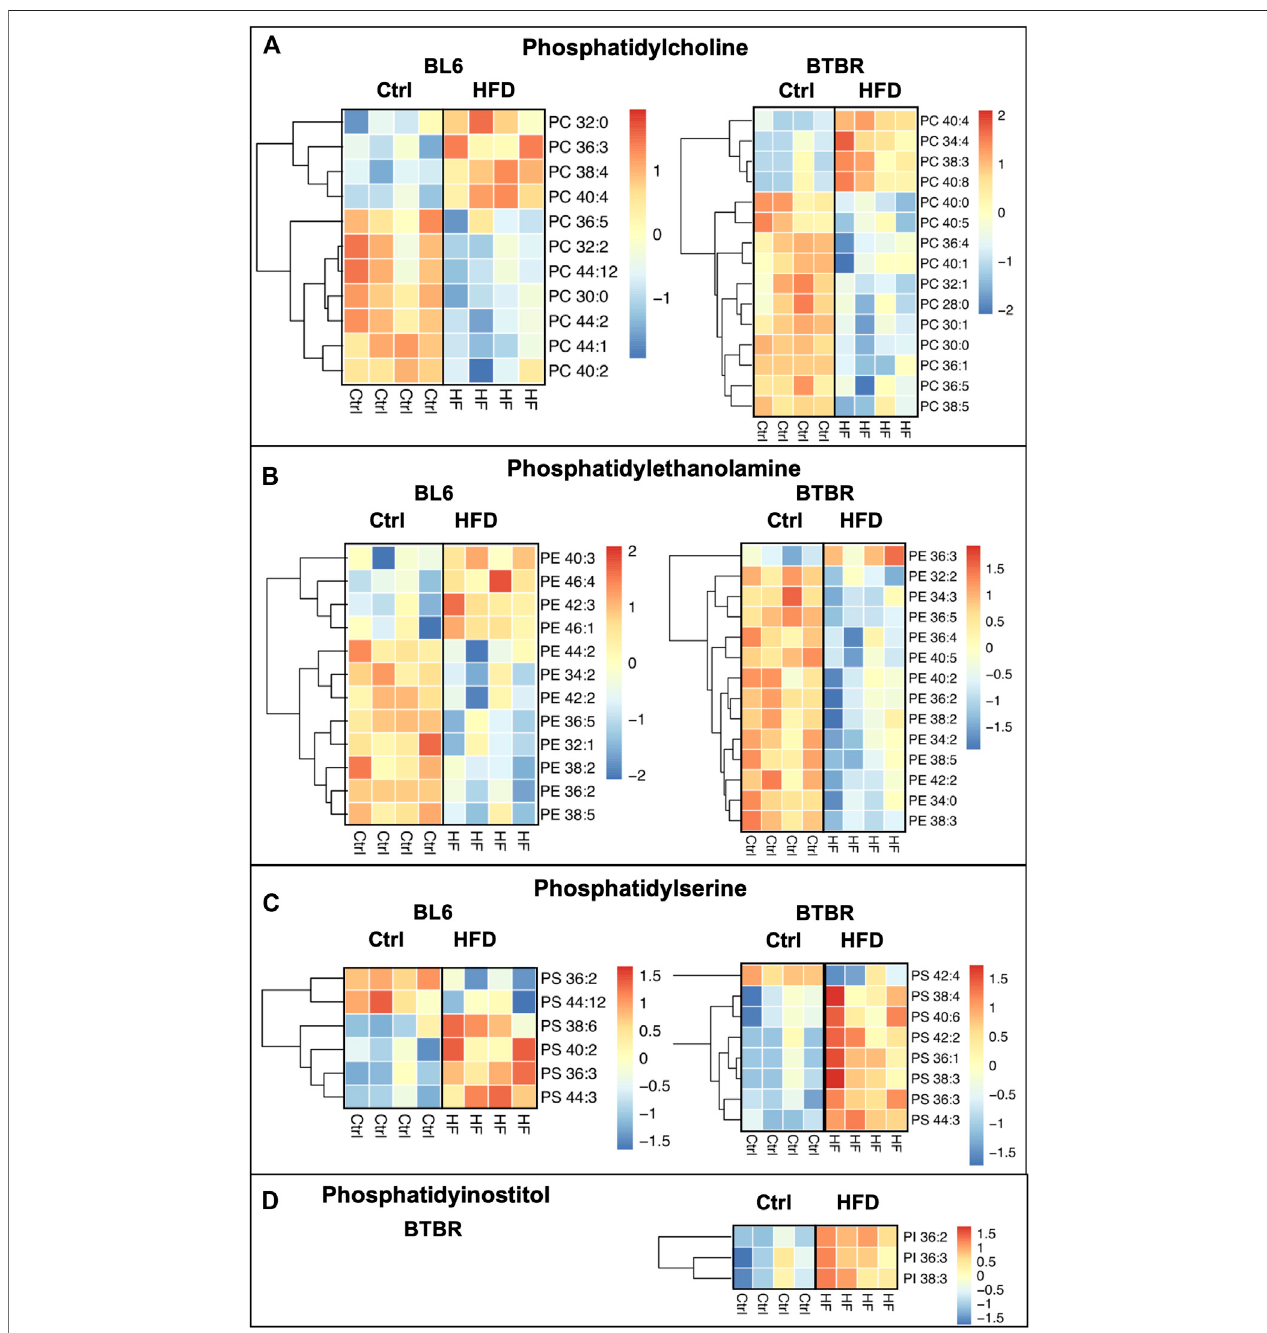
FIGURE 4 | Heat maps of BL6, BTBR, and BKS sciatic nerve phospholipids. All phospholipid levels including (A) phosphatidylcholine (PC) (B) phosphatidylethanolamine (PE) (C) phosphatidylserine (PS) and (D) phosphatidylinsotitol (PI) were altered by the HFD in BL6 and BTBR mice. t -test, p -value < 0.05.